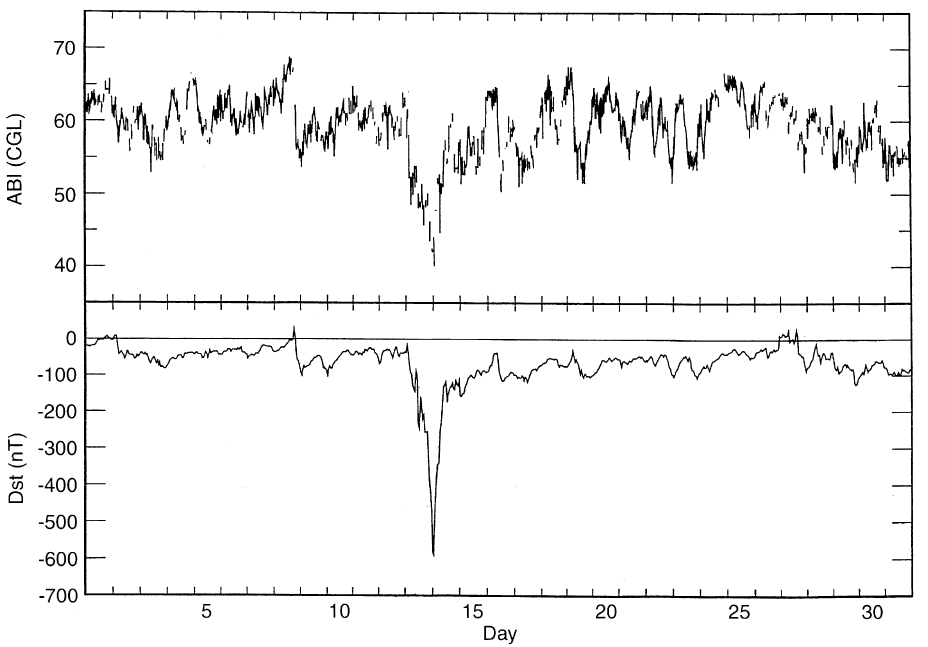
Fig. 1. Time variations of the au- roral boundary index and the Dst index for March 1989. The hori- zontal axis shows the day of month. The top panel is for the auroral boundary index and the bottom panel is for the